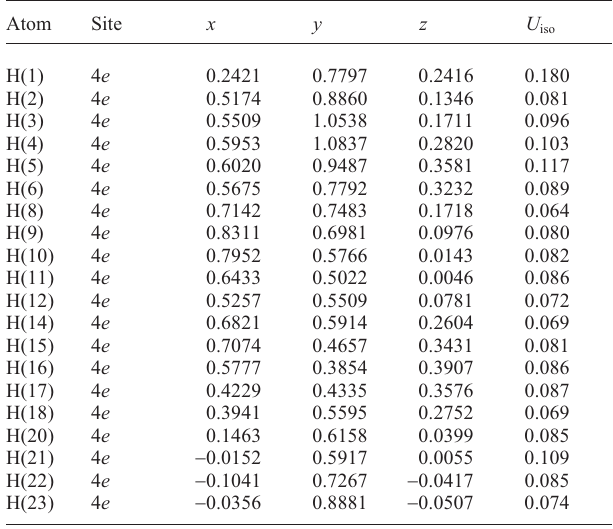
Table 2. Atomic coordinates and displacement parameters (in Å 2 )